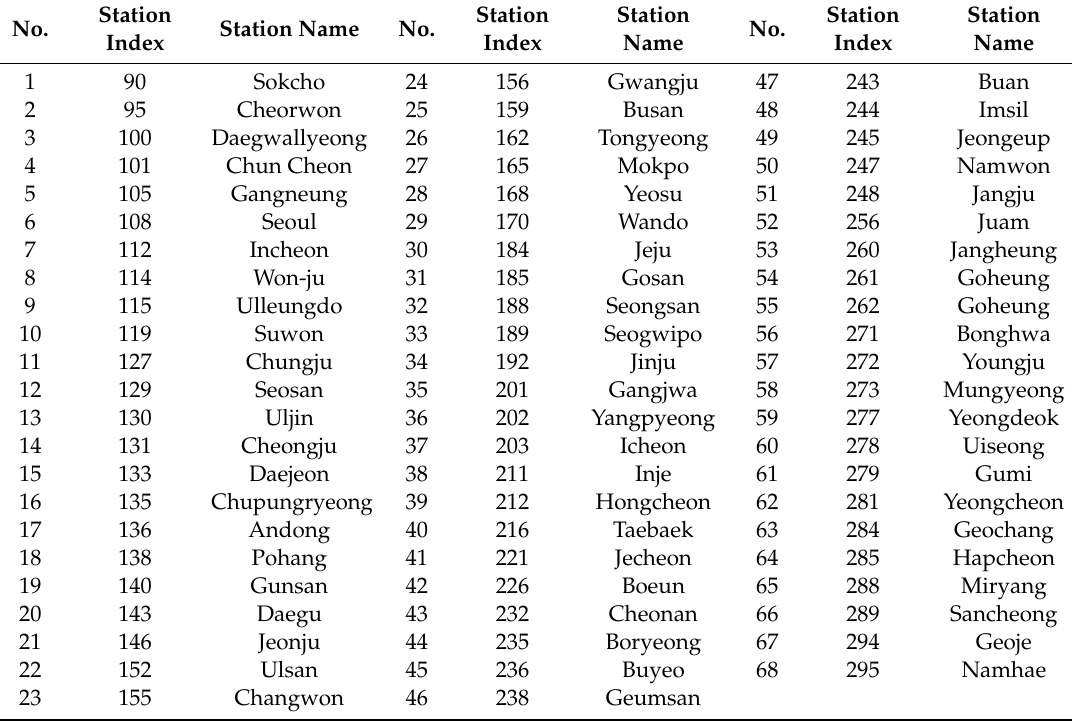
Table A1. Rainfall